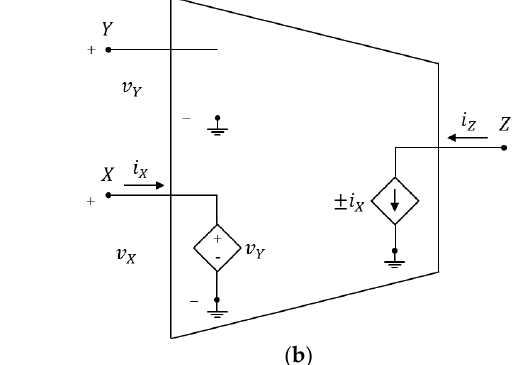
Figure 1. Second generation current conveyor: ( a ) circuit symbol, ( b ) ideal equivalent circuit.